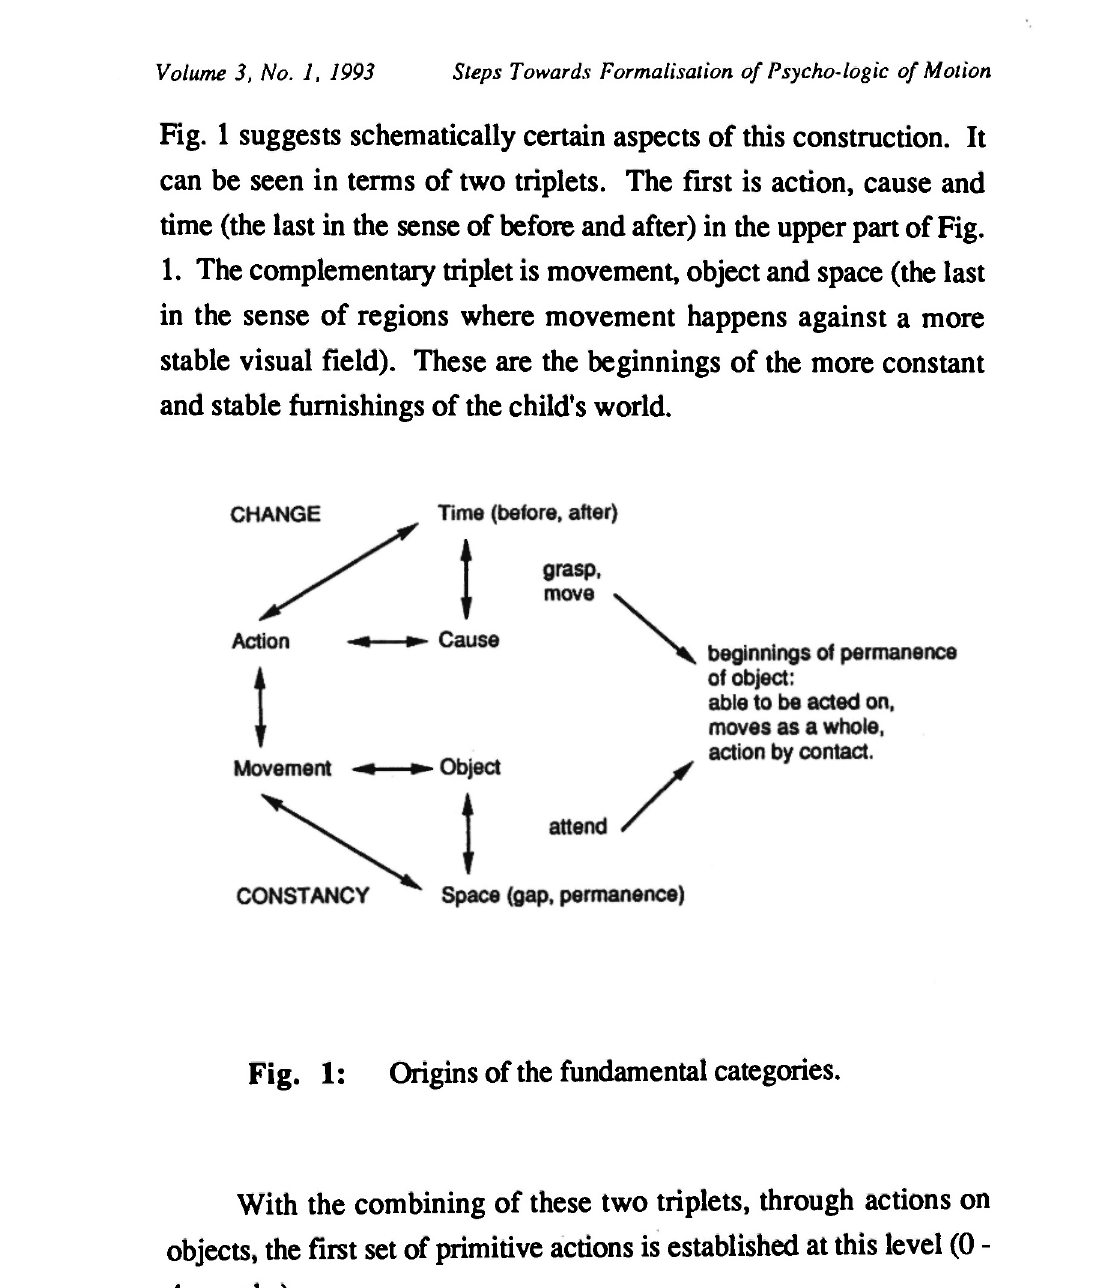
Fig. 1: Origins of the fundamental